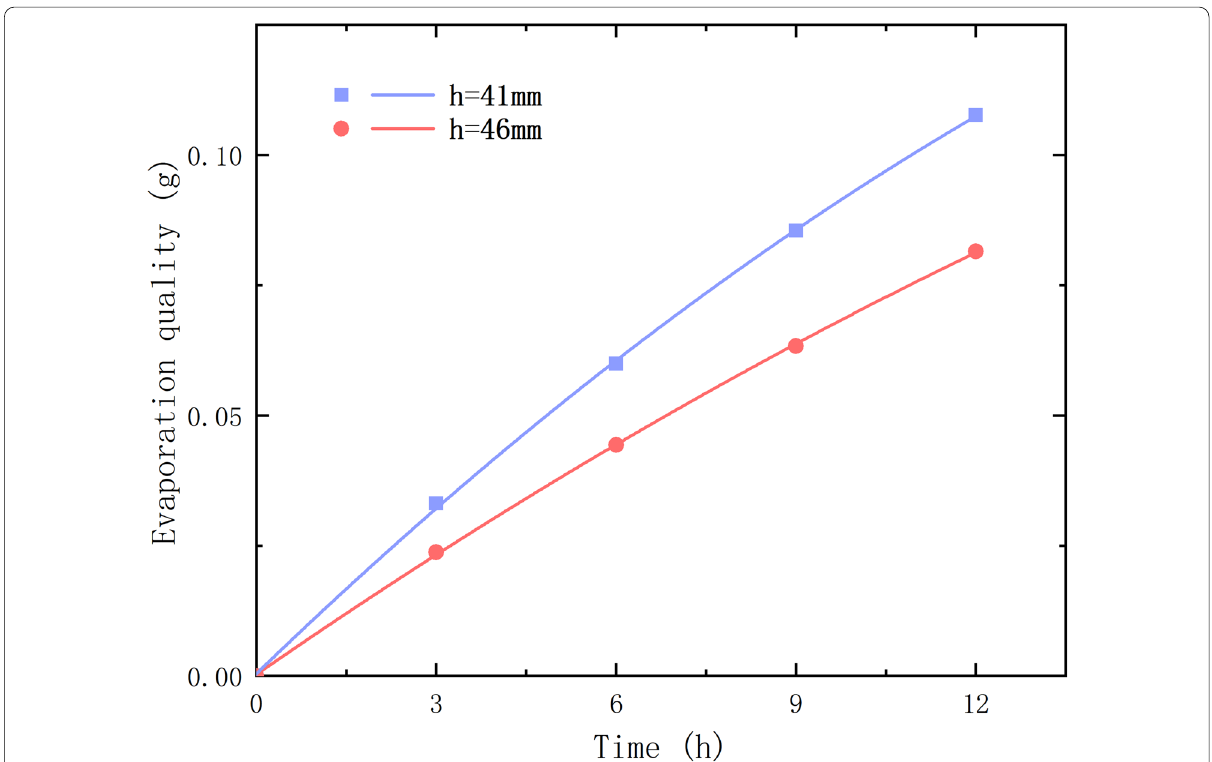
Figure 8 The weight loss of samples and their fitted curves with different